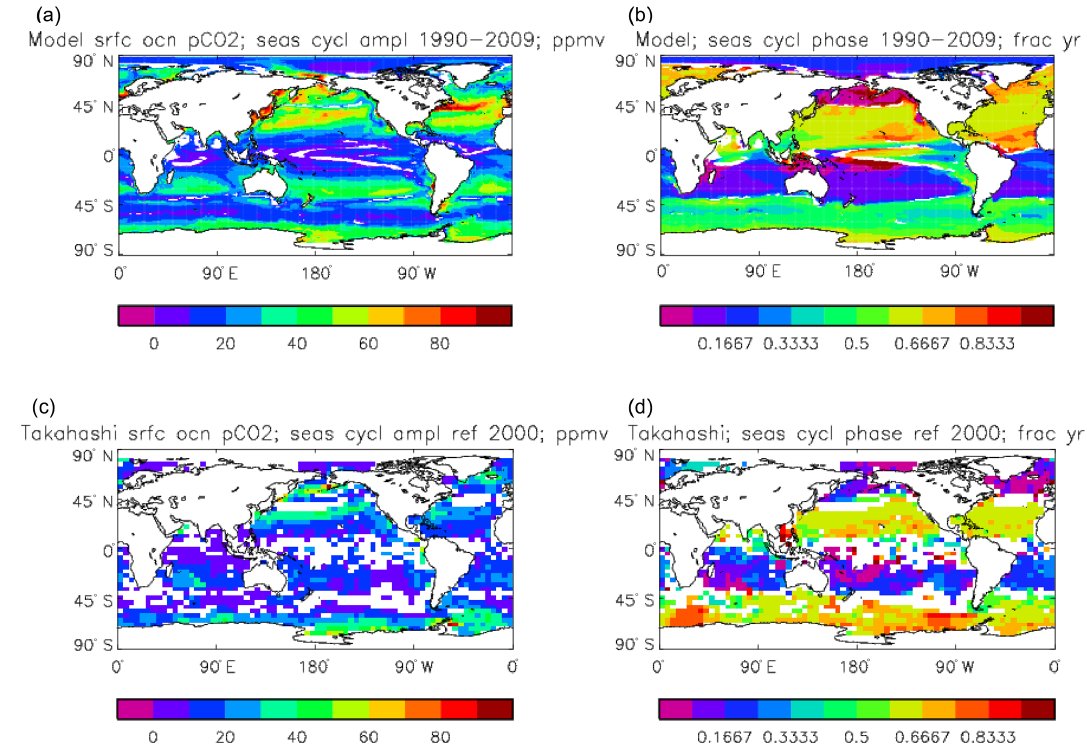
Figure 16. Surface ocean p CO 2 , seasonal cycle: (a, b) model averaged over model years 1990–2009; (c, d) Takahashi gridded data, refer- enced to the year 2000; (a, c) amplitude of the cycle (ppmv); (b, d) phase of the cycle (in fraction of year). Only points for which the residual variance is less than half the original are shown.